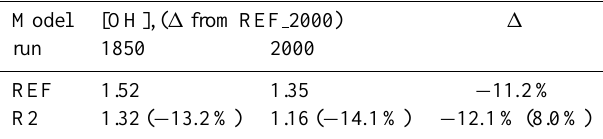
Table 2. The tropospheric, annual mean OH concentration (10 6 moleccm − 3 ), for each of the model runs. The difference ( 1 ) between the R2 and REF runs is given in brackets. The last column shows the difference between the OH concentration in 2000 and 1850 for each run, with the effect of Reaction (R2) on this change given in brackets.